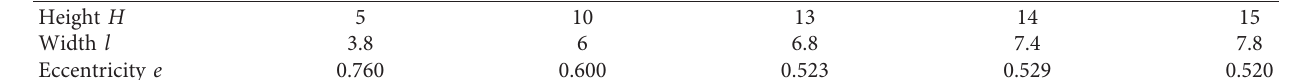
Figure 3: Coal-rock settlement curves and the evolution of the caving body. The solid line indicates the evolution of the settlement path of the top coal particles, and the dotted line represents the evolution of the caving body during the coal caving process. Table 1: Geometric parameters of the caving body.